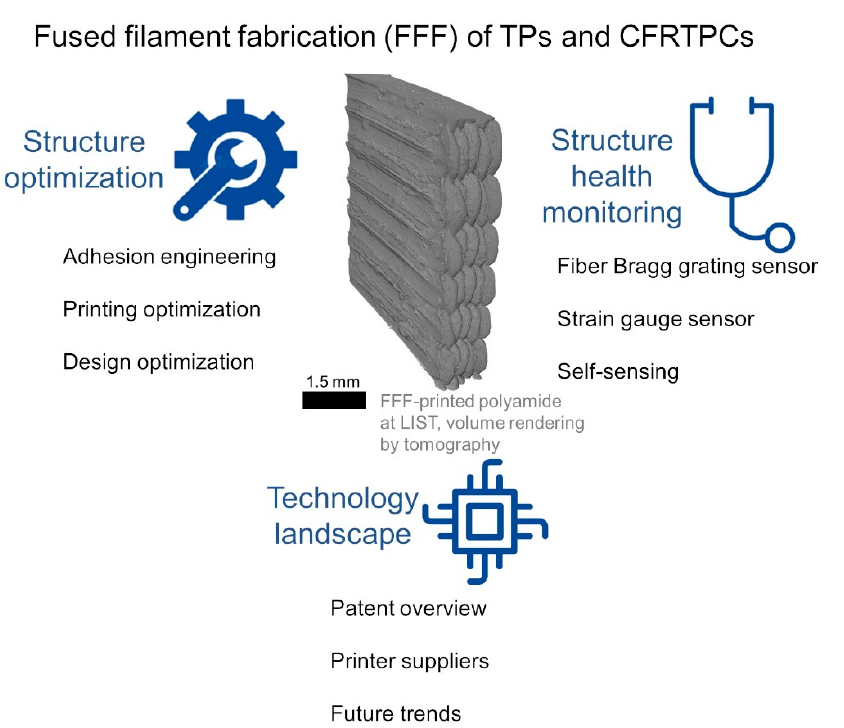
Figure 2. Scope of the present review on FFF-printing of TPs and CFRTPCs. Three pillars are addressed: structure optimization, structure health monitoring, and technology landscape.